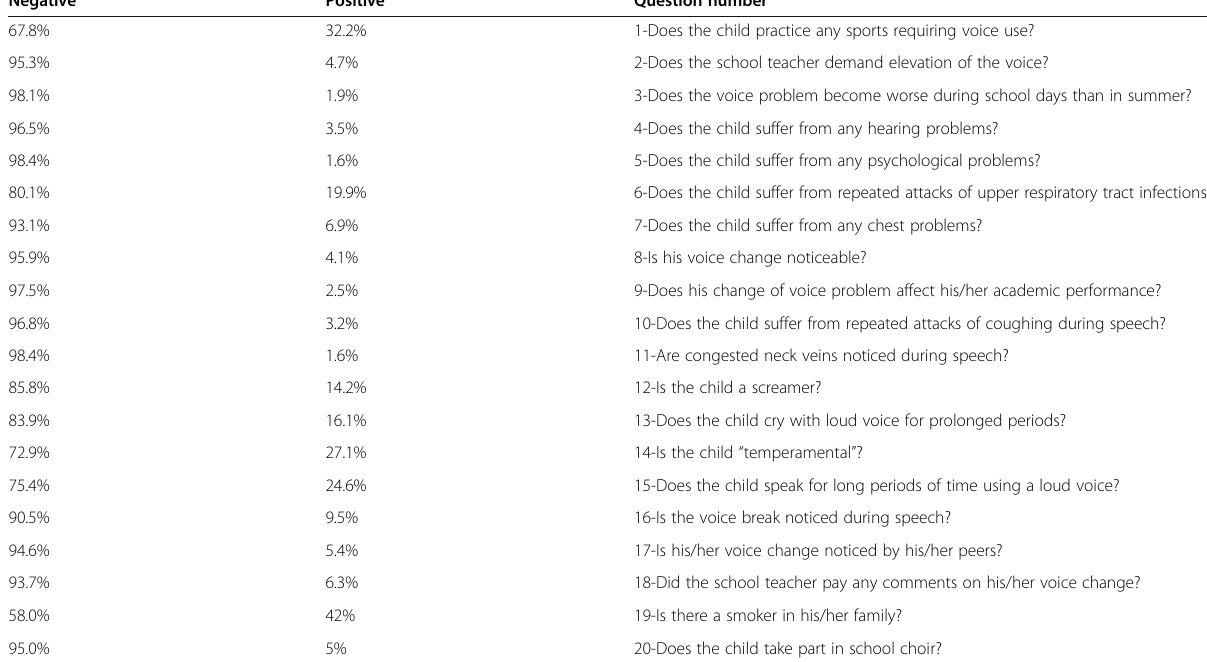
Table 1 represents the questionnaire and the responses of the studied students to the questions Negative Positive